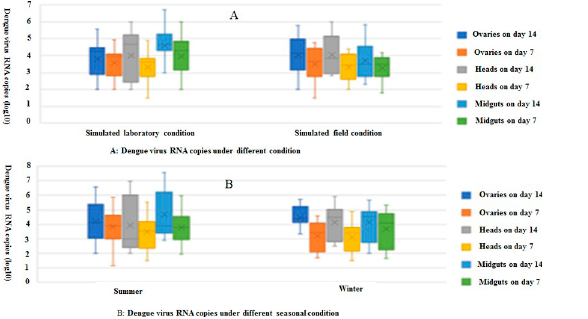
Fig 8. Amount of dengue virus in the midgut, ovary, and head of mosquitoes under different conditions. ( A) Dengue virus RNA copies under different condition. (B) Dengue virus RNA copies under different seasonal conditions.